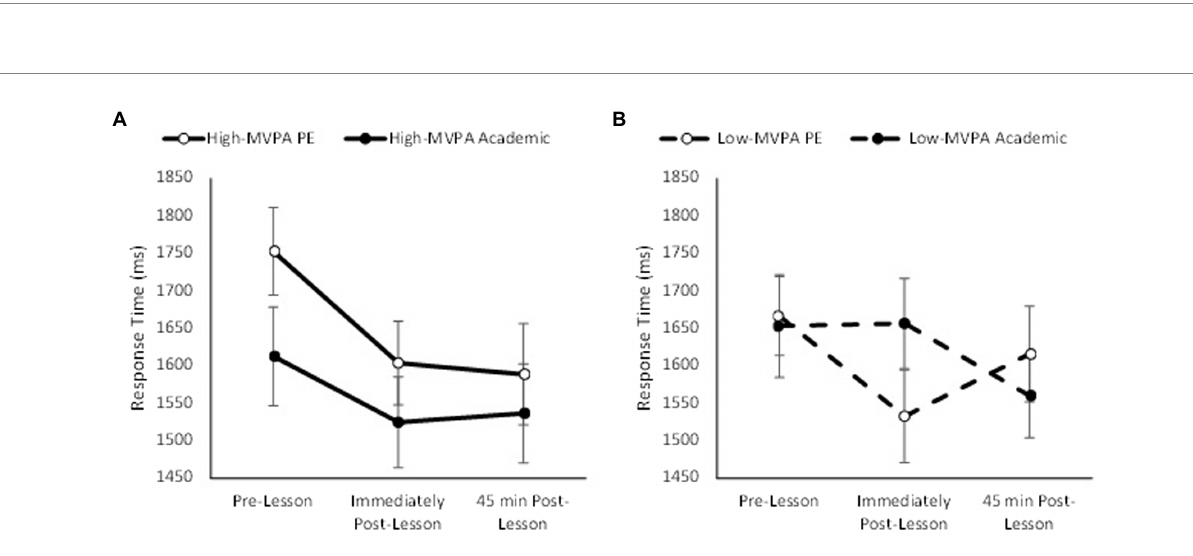
FIGURE 8 Response times across the morning on the complex level of the visual search on the PE and academic lesson trials for the high MVPA (trial * time, p = 0.265; A ) and low MVPA (trial * time, p = 0.003; B ) groups (trial * time * MVPA, p =